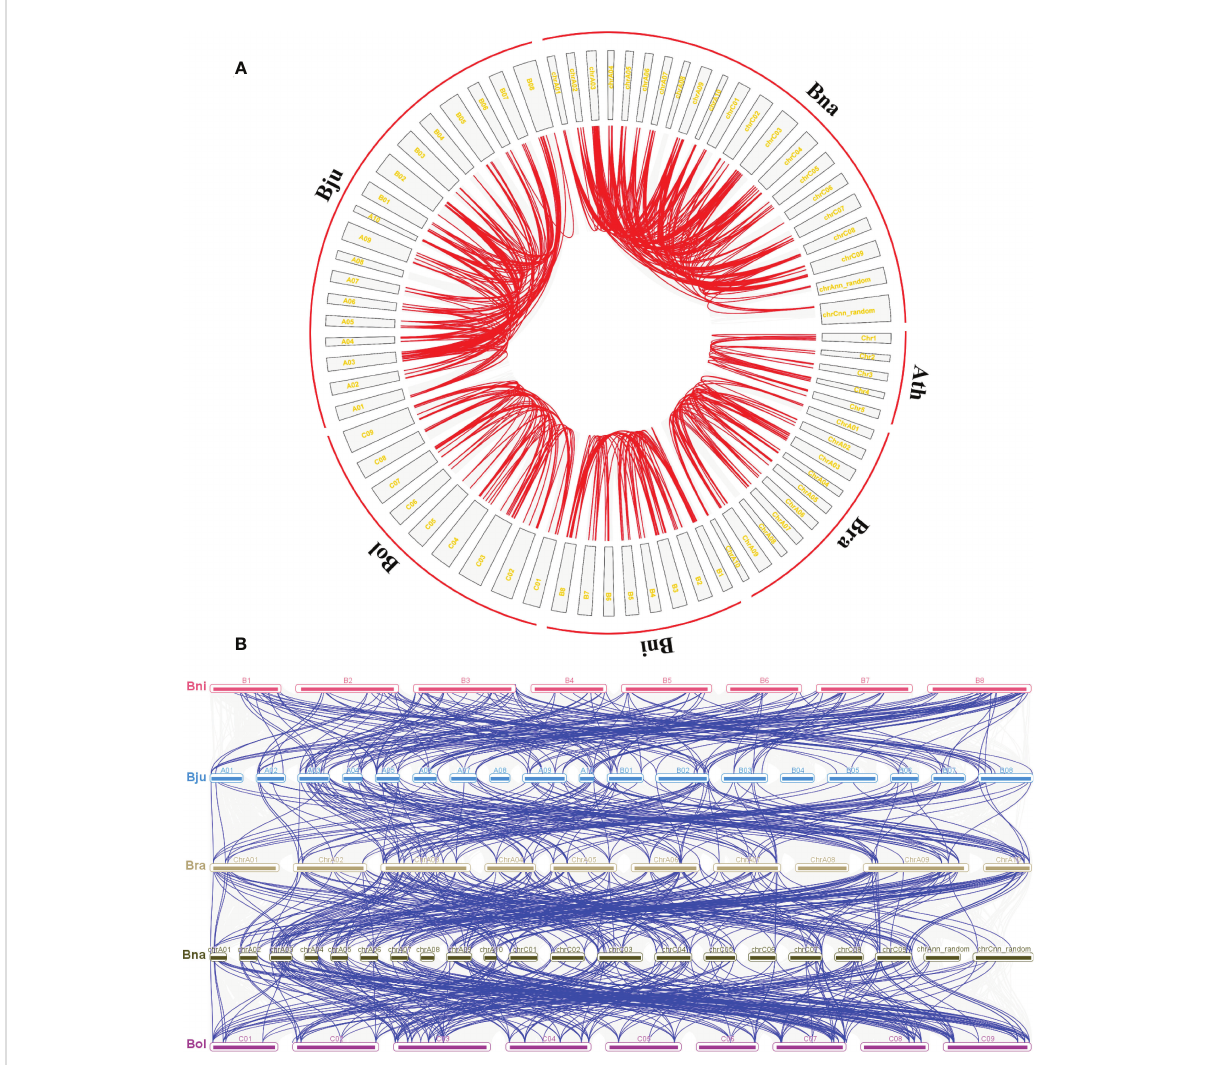
FIGURE 2 Duplication and syntenic relationship of CPK genes in fi ve Brassica species. (A) Duplication of RLP genes in A. thaliana, B. rapa, B. nigra, B. oleracea, B. juncea , and B. napus , respectively. The red line represents the gene pairs and the gray box represents the chromosome. (B) Syntenic relationship of CPK-encoding genes between B.rapa, B.nigra, B.oleracea, B.juncea , and B.napus . The blue line represents the gene pairs and the colored box represents the